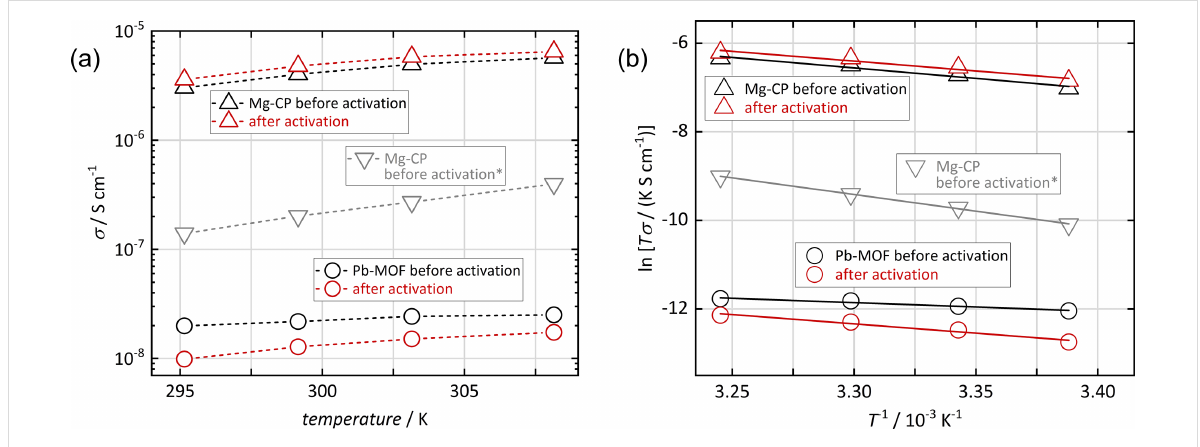
Figure 6: (a) Proton conductivity (dashed lines as guide to the eye) of [Mg(H 2 O) 2 (H 3 L)]·H 2 O (Mg-CP) and [Pb 2 (HL)]·H 2 O (Pb-MOF) at different tem- peratures (90% r.h.). (b) Arrhenius plot (with linear regression) of the same data. *The lower values for Mg-CP (gray) correspond to the conduction mode that is irreversibly erased by thermal activation.